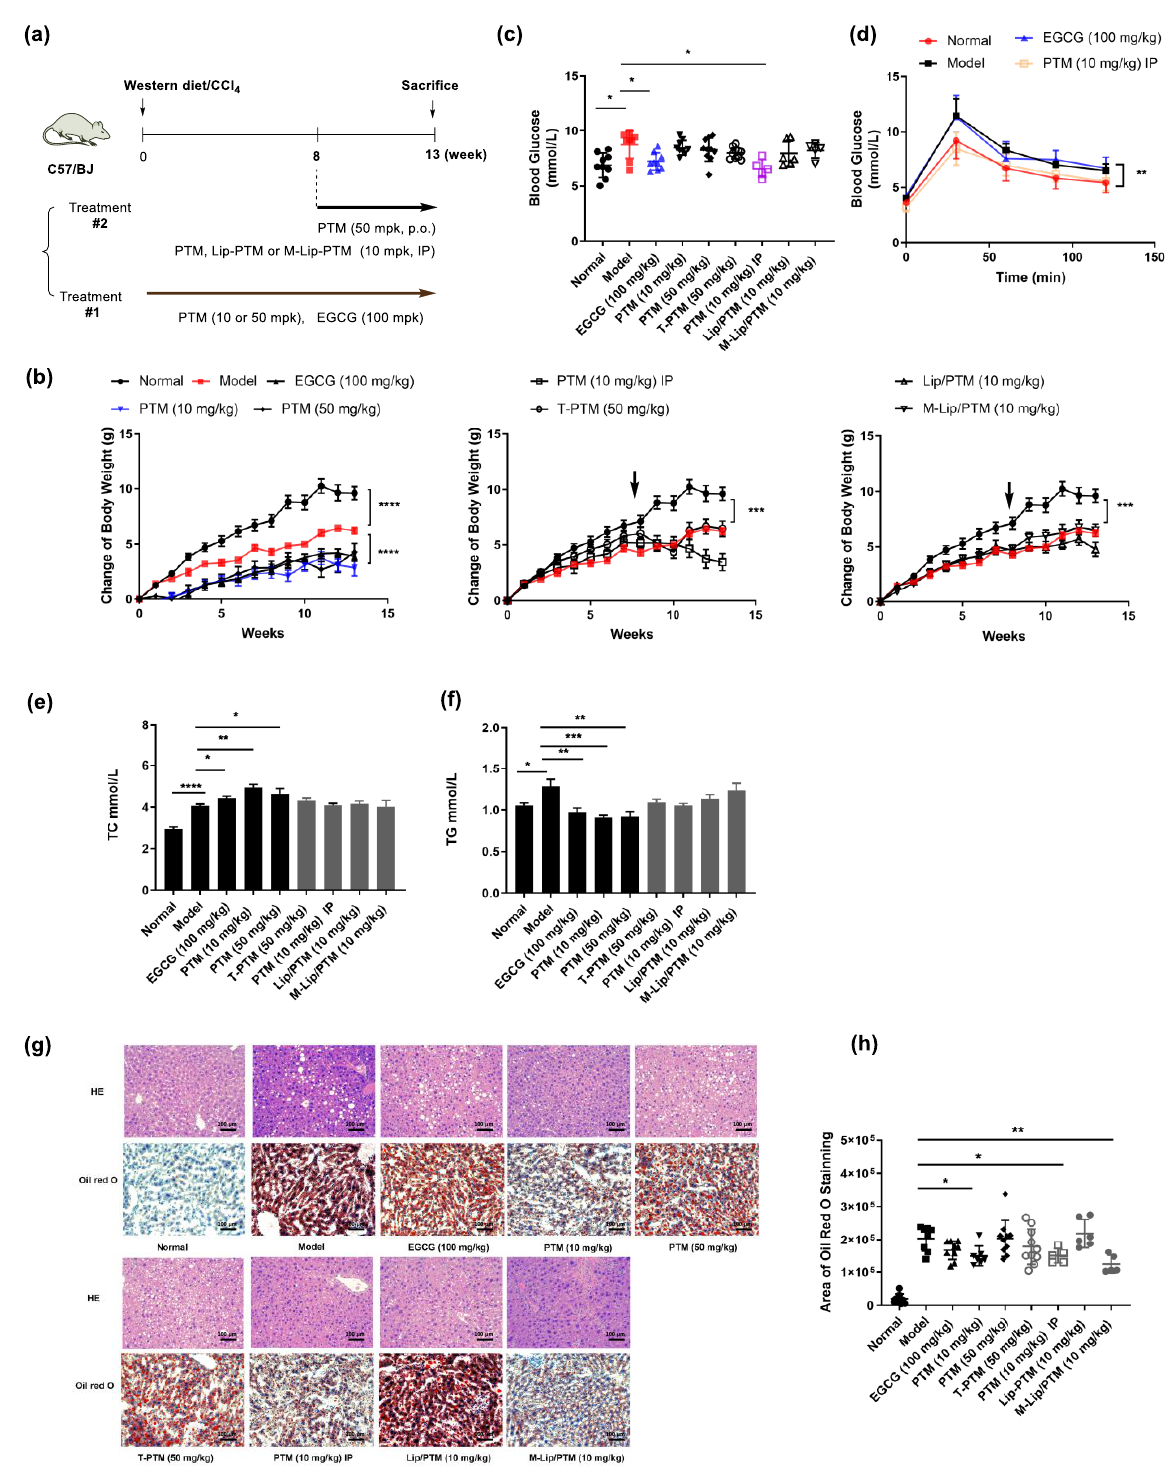
Figure 2. PTM reverses hepatic steatosis in mice induced by western diet and CCl 4 . ( a ) Schematic diagram of the experimental design for the in vivo experiments. #1: treatment for 13 weeks, #2: treatment for 5 weeks. ( b ) Body weight change. ( c ) Plasma cholesterol. ( d ) Plasma triglyceride. € Free diet blood glucose. ( f ) Oral glucose tolerance test. ( g ) Representative images of liver sections stained with H&E or Oil red O. ( h ) Quantification of Oil red O staining. Data are expressed as means ± SEMs, n = 5–10 mice per group. * p < 0.05, ** p < 0.01, *** p < 0.001, **** p <